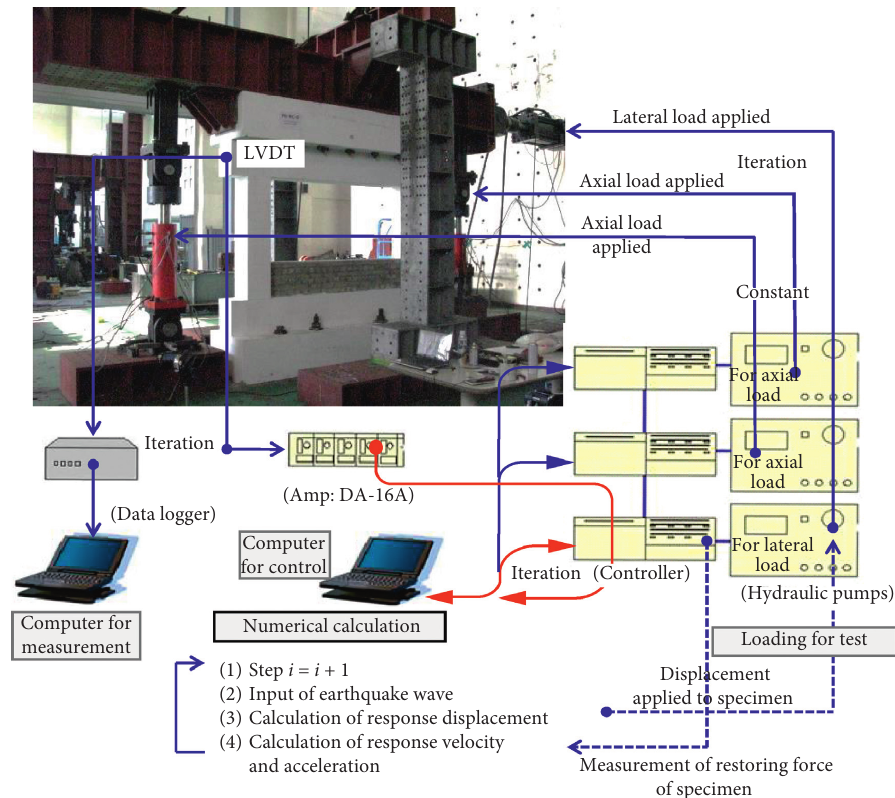
Figure 8: Simplified schematic diagram of the pseudodynamic testing system used in this